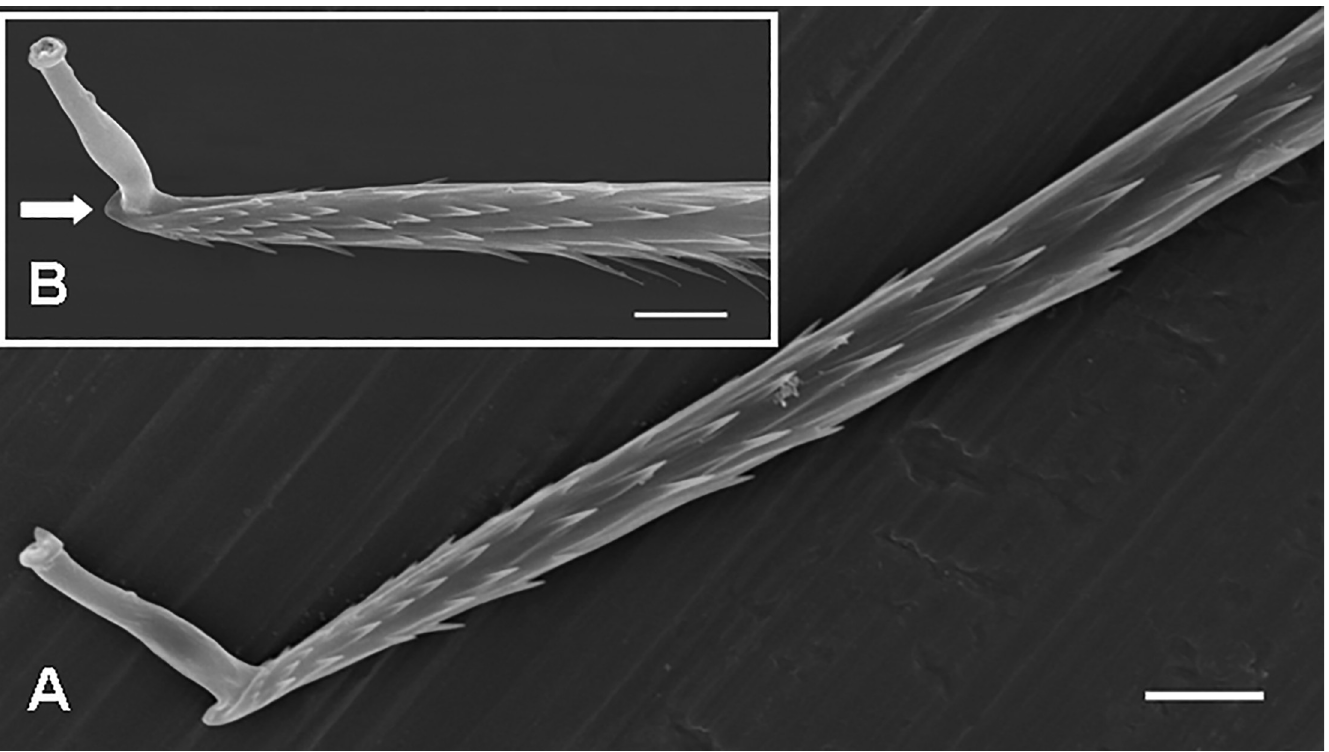
Fig 8. Urticating setae of type II in a female of Antillena rickwesti . (A) Type II, basal section with a supporting stalk, the apical section is bare. (B) Seta of intermediate morphology between body setae and type II, basal section with a supporting stalk. The arrow shows a precursor of the basal tip. Scale bar = 10 μ m.